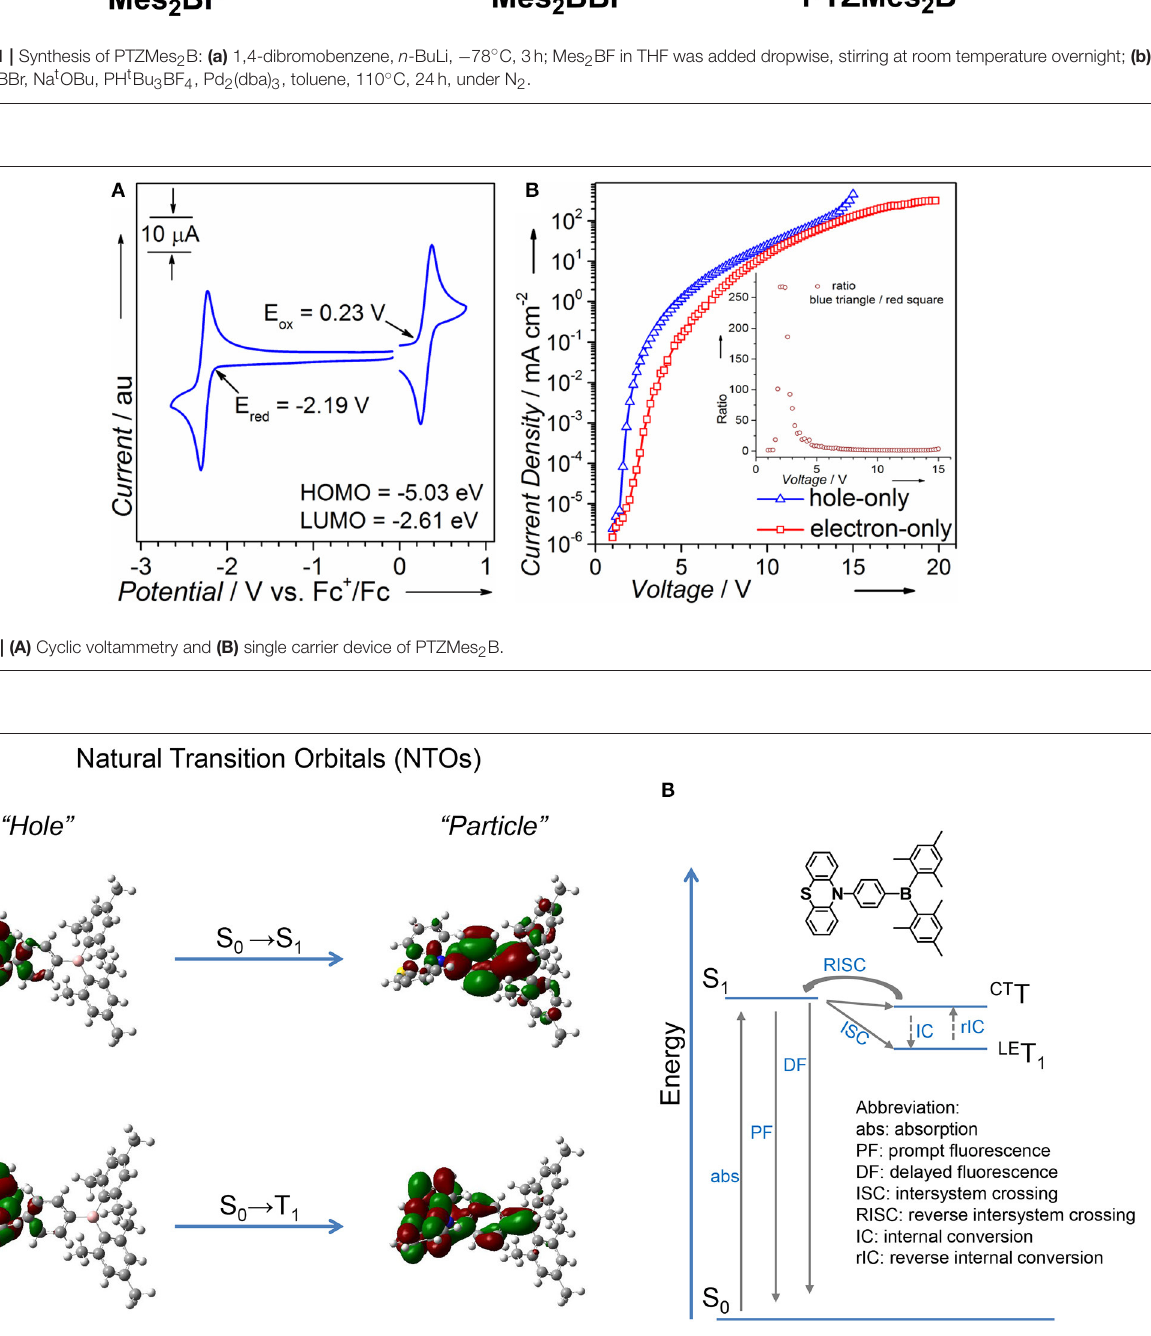
FIGURE 2 | (A) NTOs of PTZMes 2 B; (B) possible TADF route.